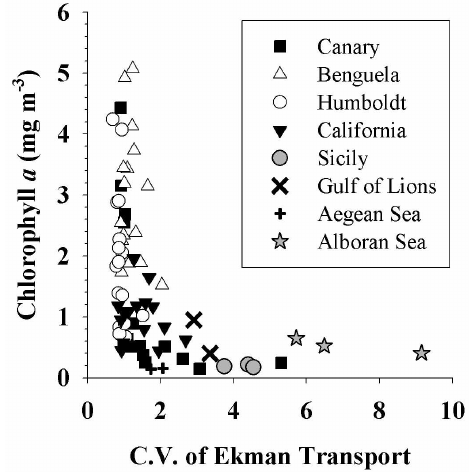
Fig . 6. – Relationship between coefficient of variation of mean an- nual Ekman transport and Chl a . Mediterranean sites’ data values are given in Table 1. Data on Canary, Benguela, Humboldt, and California EBUS regions from Patti et al .